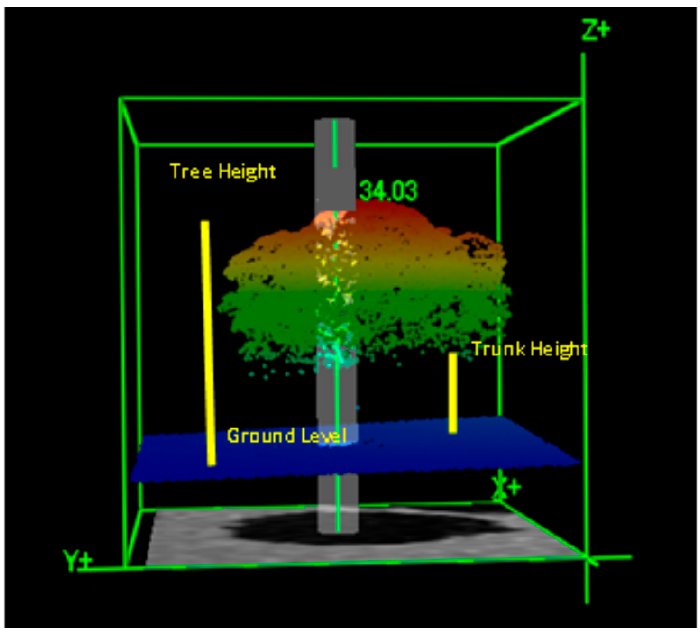
Figure 4. Tree dimensions (total tree height and trunk height) from FUSION/LDV software. The colours green, yellow and red represents the canopy at different heights. Blue represents ground level.